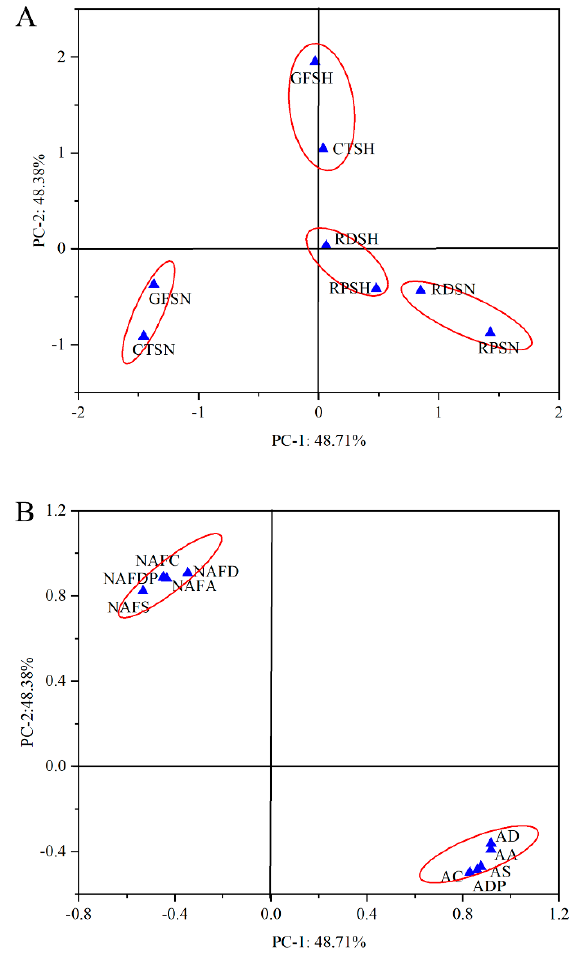
Figure 4. Principal component analysis (PCA) of different blackberry growth stages . ( A ) PCA scores map of different blackberry growth stages. ( B ) Loading map of different blackberry growth stages. Note: NAFD, non-anthocyanidin flavonoid hydroxyl radical-scavenging activities; NAFS, non-anthocyanidin flavonoid superoxide anion radical-scavenging activities; NAFA,